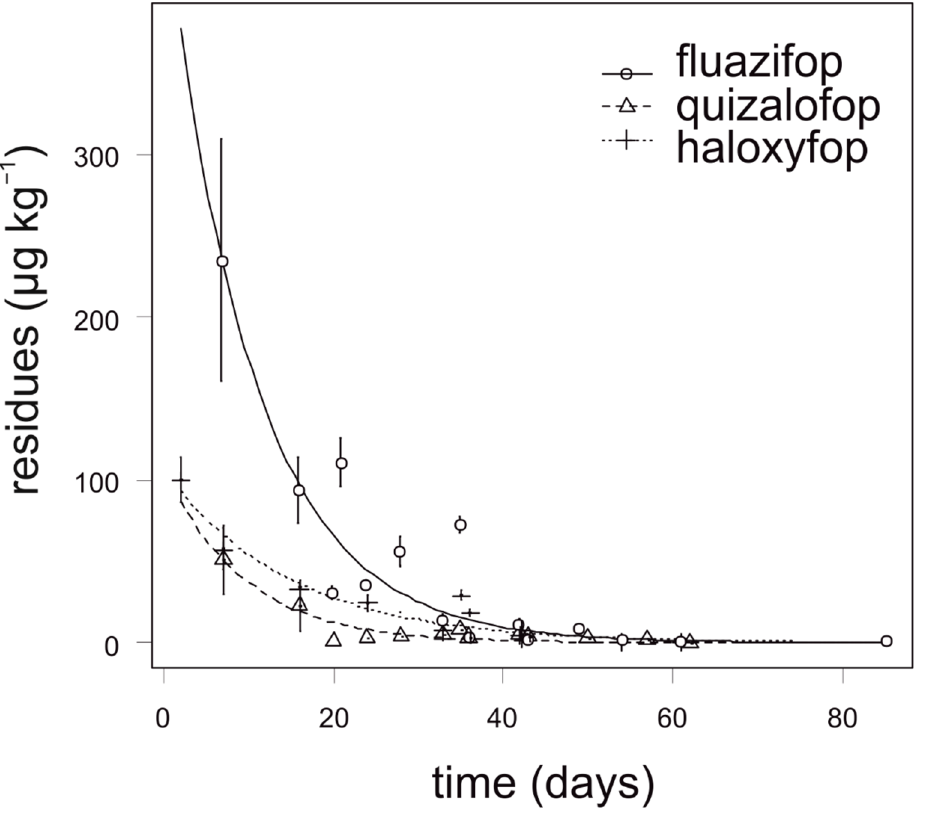
Figure 2. Degradation dynamics of fluazifop, quizalofop, and haloxyfop in onion. Mean values with error bars representing standard error of the mean.